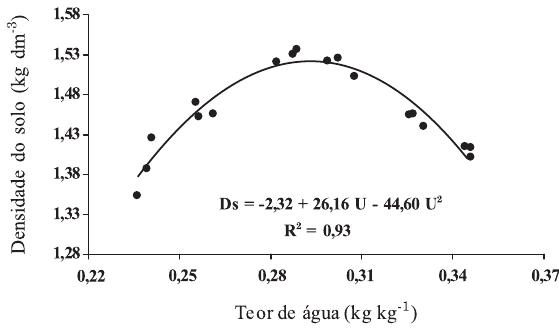
Figura 1. densidade do solo (ds) em função do teor de água (u) determinada por meio do teste de